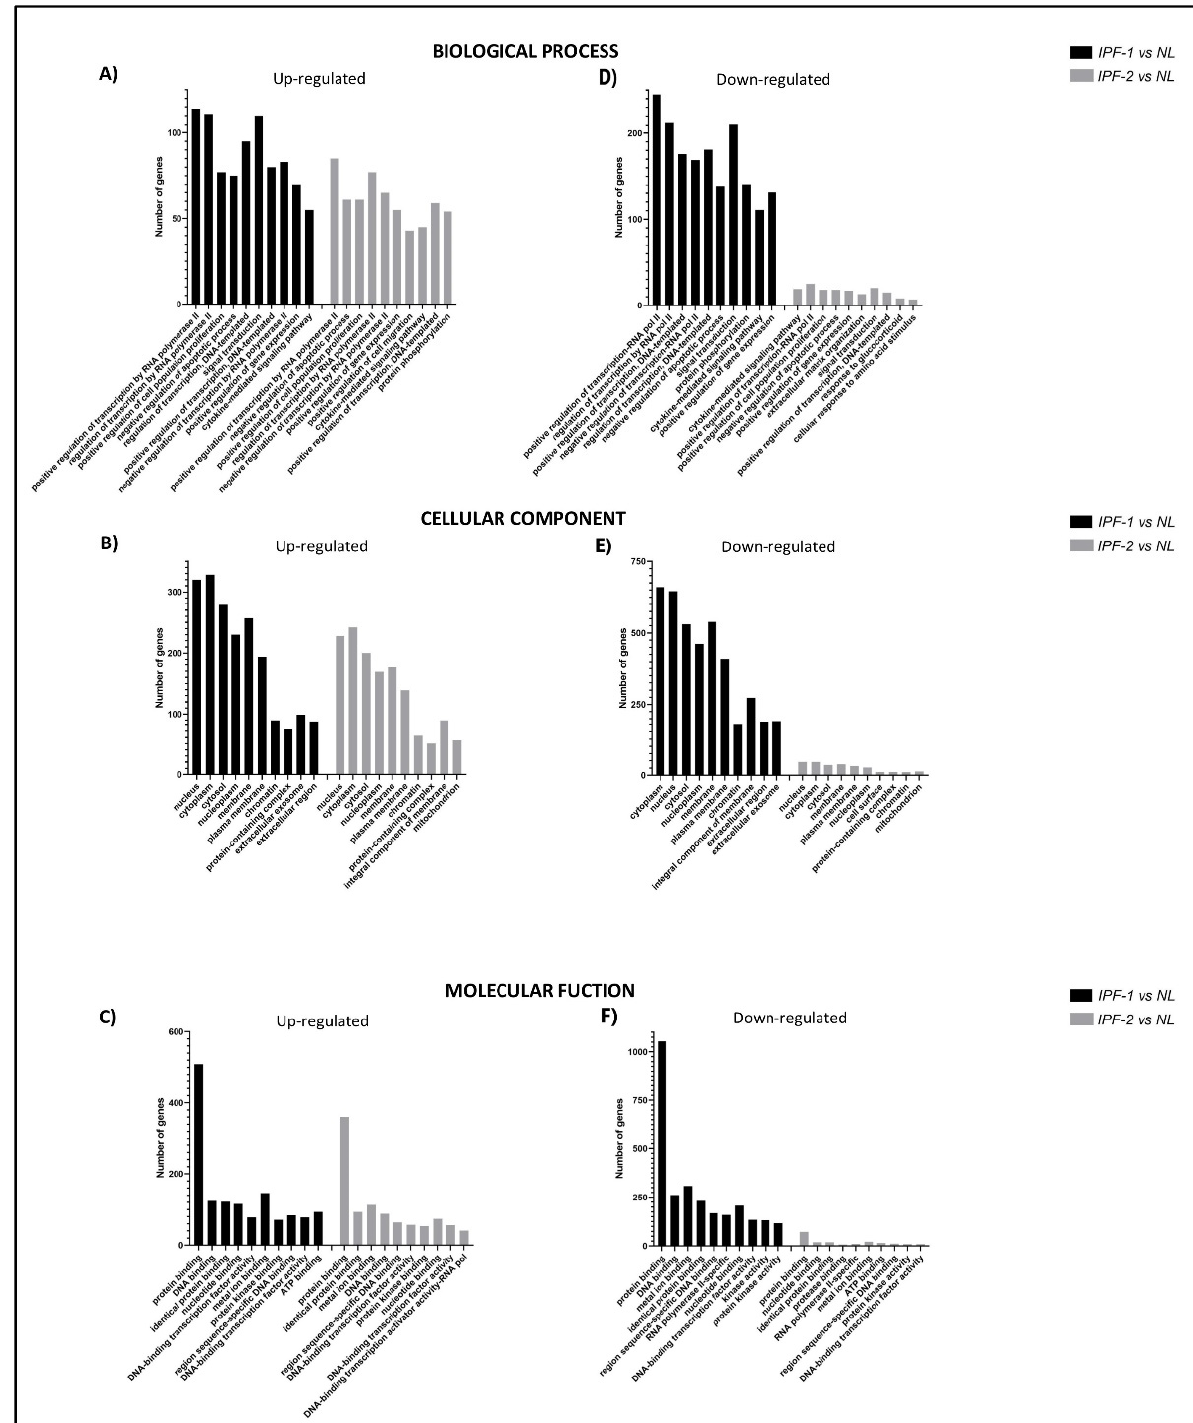
Figure 3 . Gene ontology enrichment analysis of target genes regulated by DE-miRNAs in EVs. Using the top DE-miRNAs, gene ontology was determined using the GeneCodis platform. ( A – C ) Top 10 target gene terms in Biological Processes, Cellular Components, and Molecular Functions category for upregulated miRNAs. ( D – F ) 10 classes with the highest number of target genes in GO categories for downregulated miRNAs. The x -axis shows GO terms of ontologies, and the y -axis indicates the number of target genes annotated in GO terms.